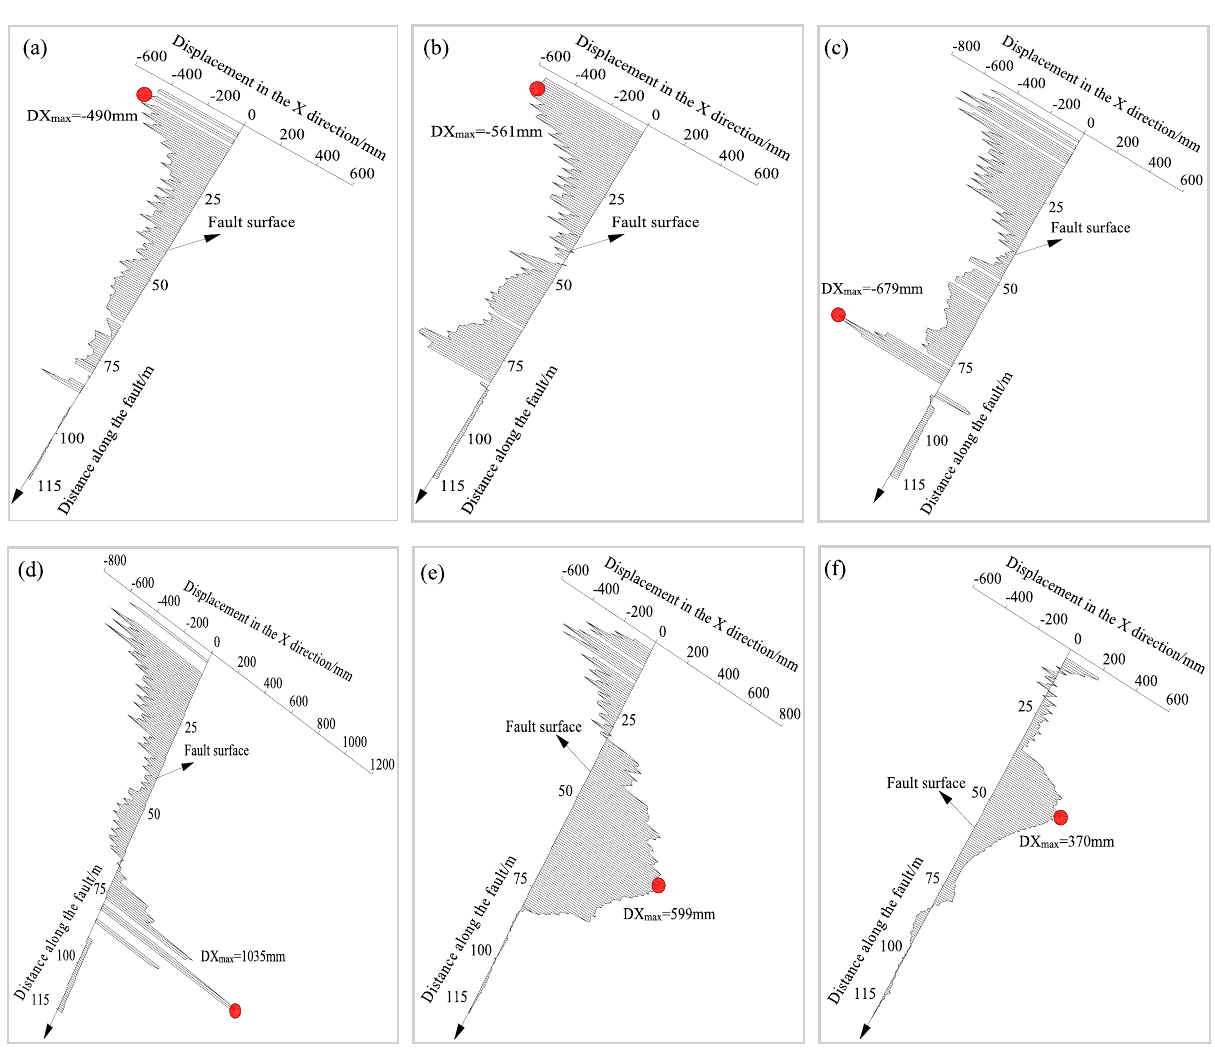
Figure 18. Evolutionary process of the horizontal displacement along the fault plane under different roadway formation